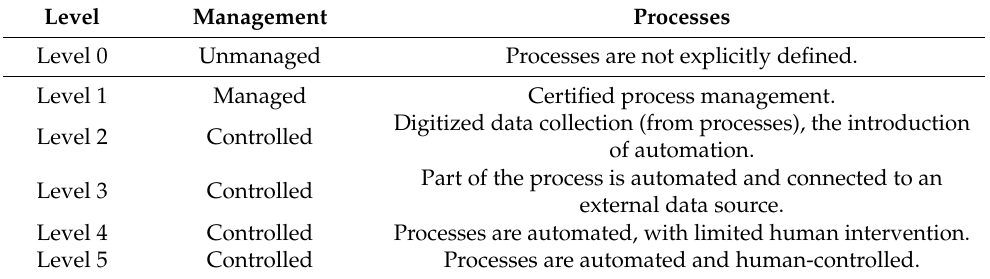
Table 1. Six levels of